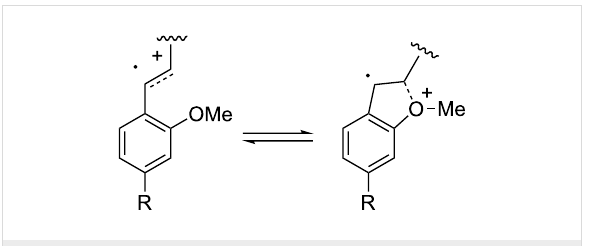
Figure 1: Radical cation stabilization by an o -methoxy